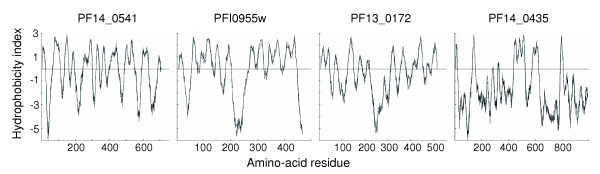
Comparison of the hydropathy plots of three P. falciparum proteins designated as putative transport proteins (PF14_0541, PFI0955w and PF13_0172) with that of a protein designated as having no putative function (PF14_0435). The PF14_0541 protein is a putative V-type H+-pumping pyrophosphatase (H+-PPase) and its hydropathy plot shows around 15 peaks in the hydrophobicity index, corresponding to 15 predicted transmembrane domains (TMDs) - as is characteristic of H+-PPases. The PFI0955w protein is a putative sugar transporter of the major facilitator superfamily (MFS) and its hydropathy plot indicates the presence of 12 TMDs. The PF13_0172 protein bears no sequence similarities with any known or putative transport proteins but its hydropathy plot shows around 11 peaks in the hydrophobicity index and resembles that of a typical transporter (for example, PF14_0541 or PFI0955w). The PF14_0435 protein has no non-Plasmodium sequence homologs or similarities to conserved domains, and although it is predicted to possess eight or nine putative TMDs, the hydropathy plot of the PF14_0435 protein does not resemble that of a typical transporter. The predicted TMDs are irregularly spaced (those in typical transporters tend to show more regularity of spacing, as in the first three hydropathy plots shown) and there are several very large extramembrane domains interspersed among the TMDs (many transporters have a single large extramembrane domain in the middle of the protein, but it is unusual for there to be multiple, irregularly spaced extramembrane domains of the type evident in PF14_0435). The possibility that the PF14_0435 protein (and others like it) is a transporter can certainly not be excluded; however there is simply not sufficient evidence to warrant its classification as such in the present study. The hydropathy plots were generated using the TMpred server [114].